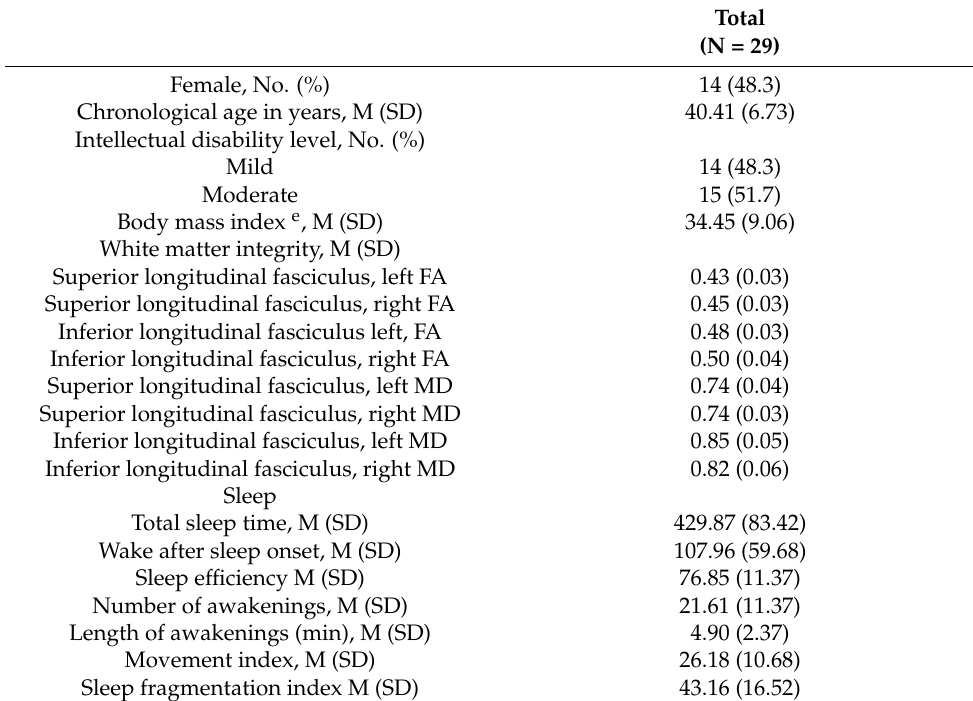
Table 1. Participant characteristics and mean and Standard Deviation for the study